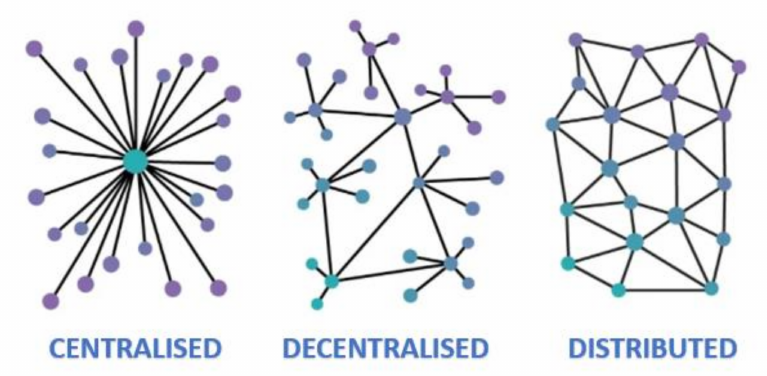
Figure 2. Centralised vs. Decentralised vs. Distributed Networks. Centralised and decentralised networks refer to the level of control of the